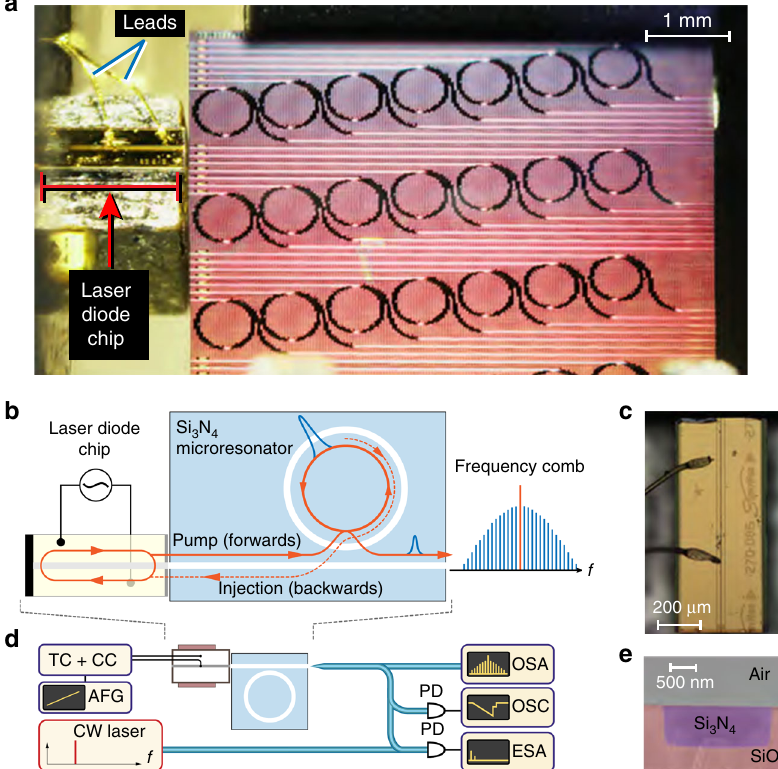
Fig. 1 Principle of an ultra-compact, laser injection-locked soliton Kerr frequency comb. a Close-range photo of the experimental setup, in which the laser diode chip is butt-coupled to a Si 3 N 4 photonic chip, which contains several microresonators. b Schematic representation of the laser injection-locked soliton Kerr frequency comb. An InP multi-frequency laser diode chip is directly butt-coupled to a Si 3 N 4 photonic chip with a microresonator. c An optical image of the InP laser diode chip showing the magni fi ed view. d Sketch of the experimental setup. The microresonator device output is characterized both in the optical domain using an optical spectral analyzer and in the radio frequency (RF) domain using an electrical-signal spectral analyzer. In addition, to assess the coherence of the frequency comb, we employ a heterodyne beatnote measurement to a selected comb tooth with a narrow linewidth reference laser. TC: temperature control module; CC: current control module; AFG: arbitrary function generator; OSA: optical spectral analyzer; OSC: oscilloscope; ESA: electrical-signal spectral analyzer. e False-colored scanning electron micrograph (SEM) image of the waveguide cross-section. The Si 3 N 4 waveguide (blue) has no top SiO 2 cladding but only side and bottom SiO 2 cladding